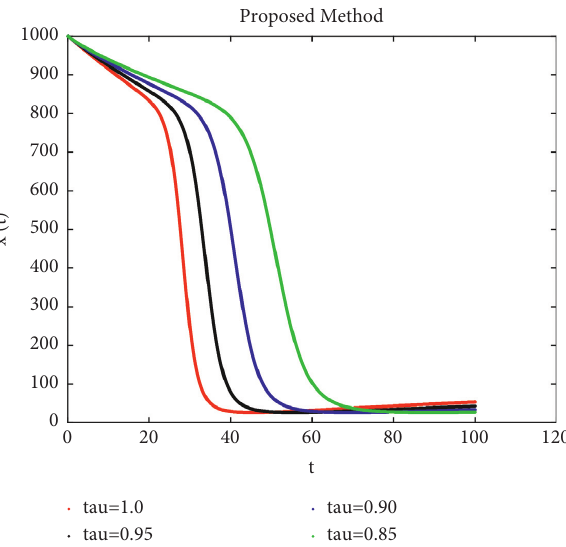
Figure 12: Dynamical behavior of concentration of uninfected (susceptible) cells at α � 1 and various fractal order � 0.85, 0.9, 0.95, 1 under Mittag-Leffler